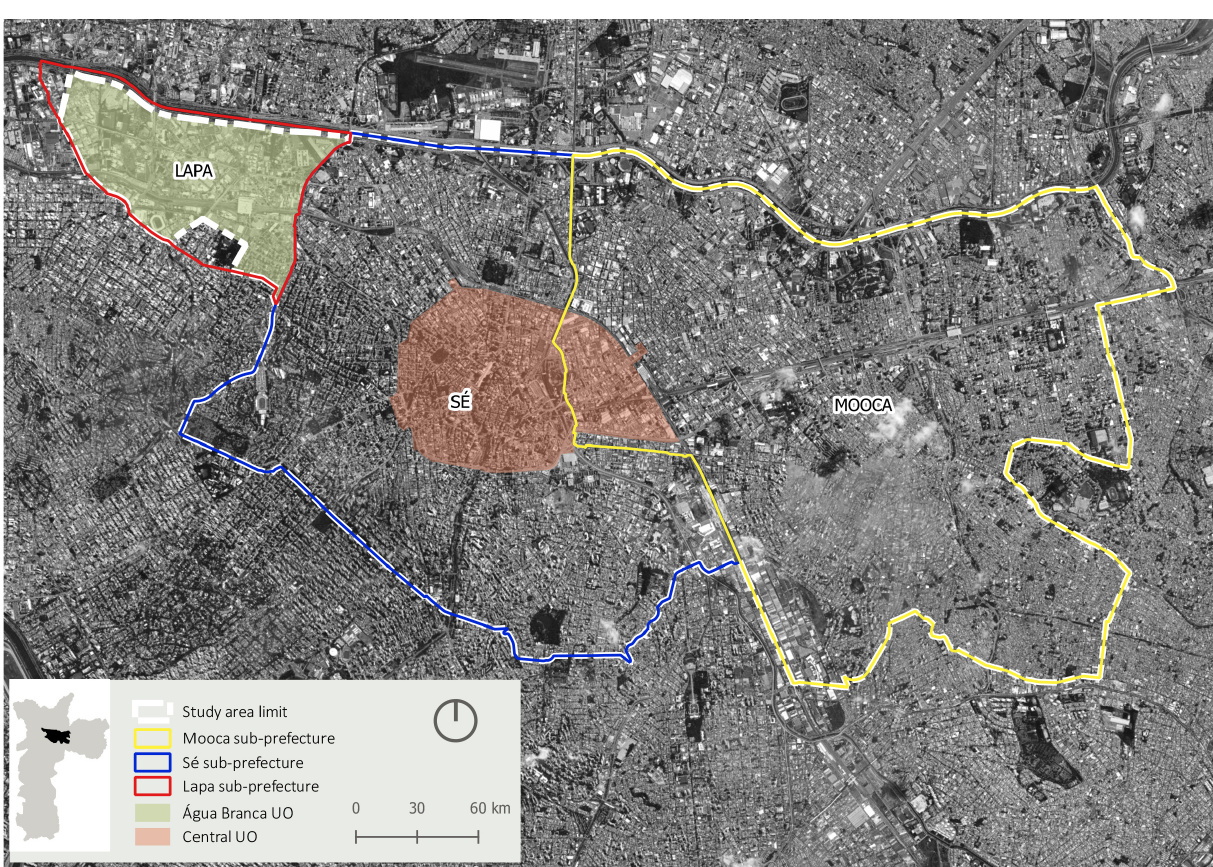
Figure 2. Study area in the central region of São